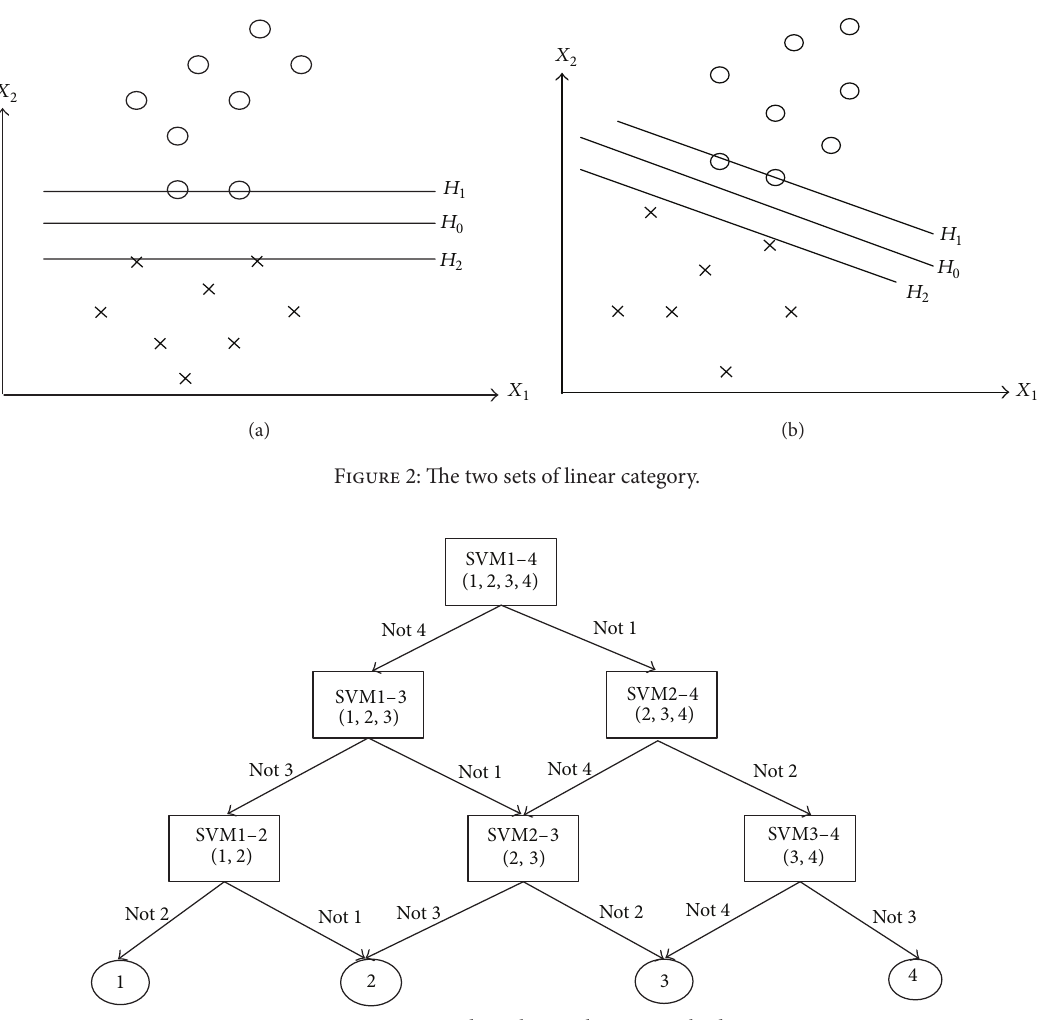
Algorithm 2. The algorithm is based on training process of multiclass classification algorithm of support vector machine based on binary